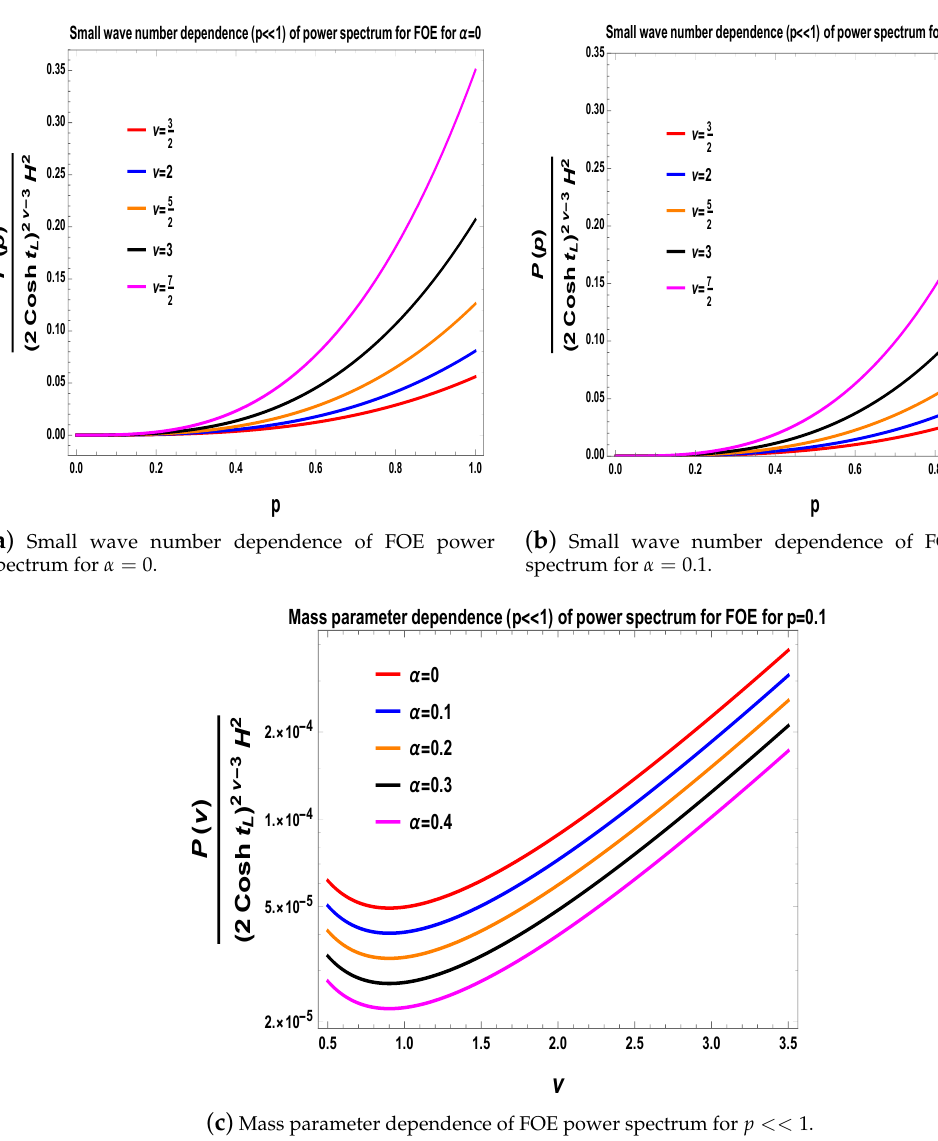
Figure 7. Features of FOE power spectrum in small wave number region. ( a ) Small wave number dependence of FOE power spectrum for α = 0; ( b ) Small wave number dependence of FOE power spectrum for α = 0.1; ( c ) Mass parameter dependence of FOE power spectrum for p <<